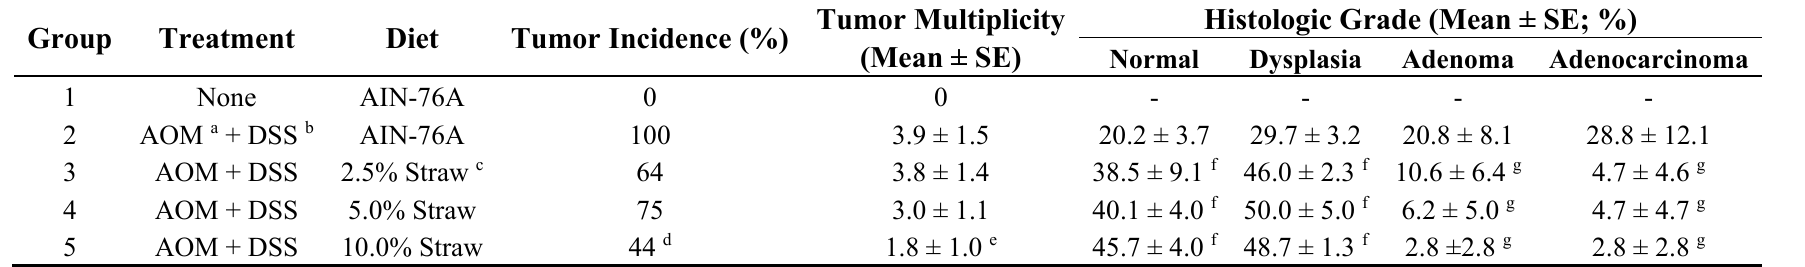
Table 1. Effect of strawberries on AOM/DSS-induced colorectal cancer (CRC) in